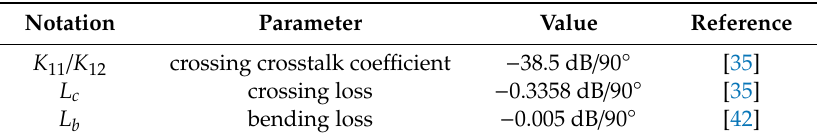
Figure 6. ( a ) WDM-based optimized crossbar (WOPC) optical router; ( b ) WDM-based crux (WCX) optical router. Table 1. Parameters of waveguide crossing and bending.